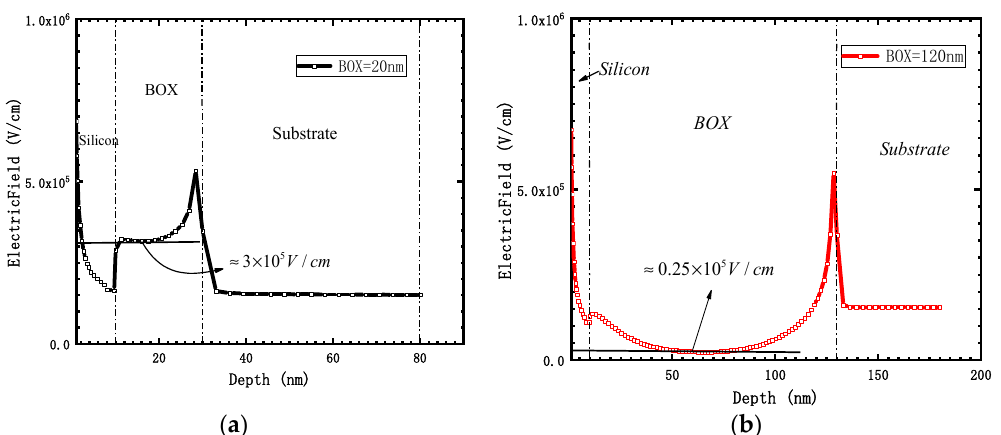
Figure 11. Tangent diagram of vertical distribution of electric field, ( a ) BOX = 20 nm; ( b ) BOX = 120 nm.